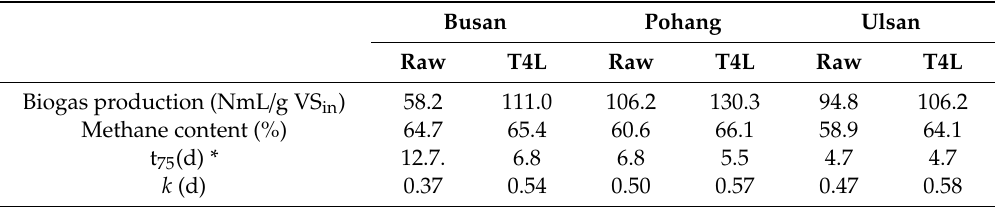
Table 5. Summary of biogas production and reaction rate coe ffi cients ( k ) in the BMP test. Busan Pohang Ulsan Raw T4L Raw T4L Raw T4L Biogas production (NmL / g VS in ) 58.2 111.0